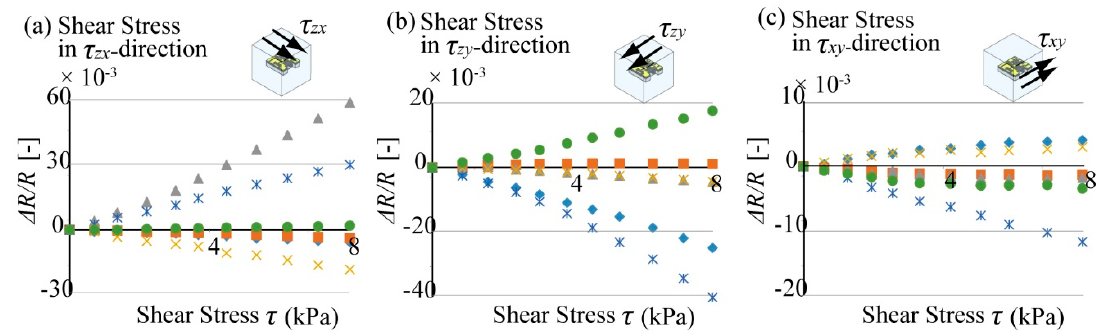
Figure 14. Sensor outputs under shear stresses; ( a ) responses to τ zx , ( b ) responses to τ zy , and ( c ) responses to τ xy .